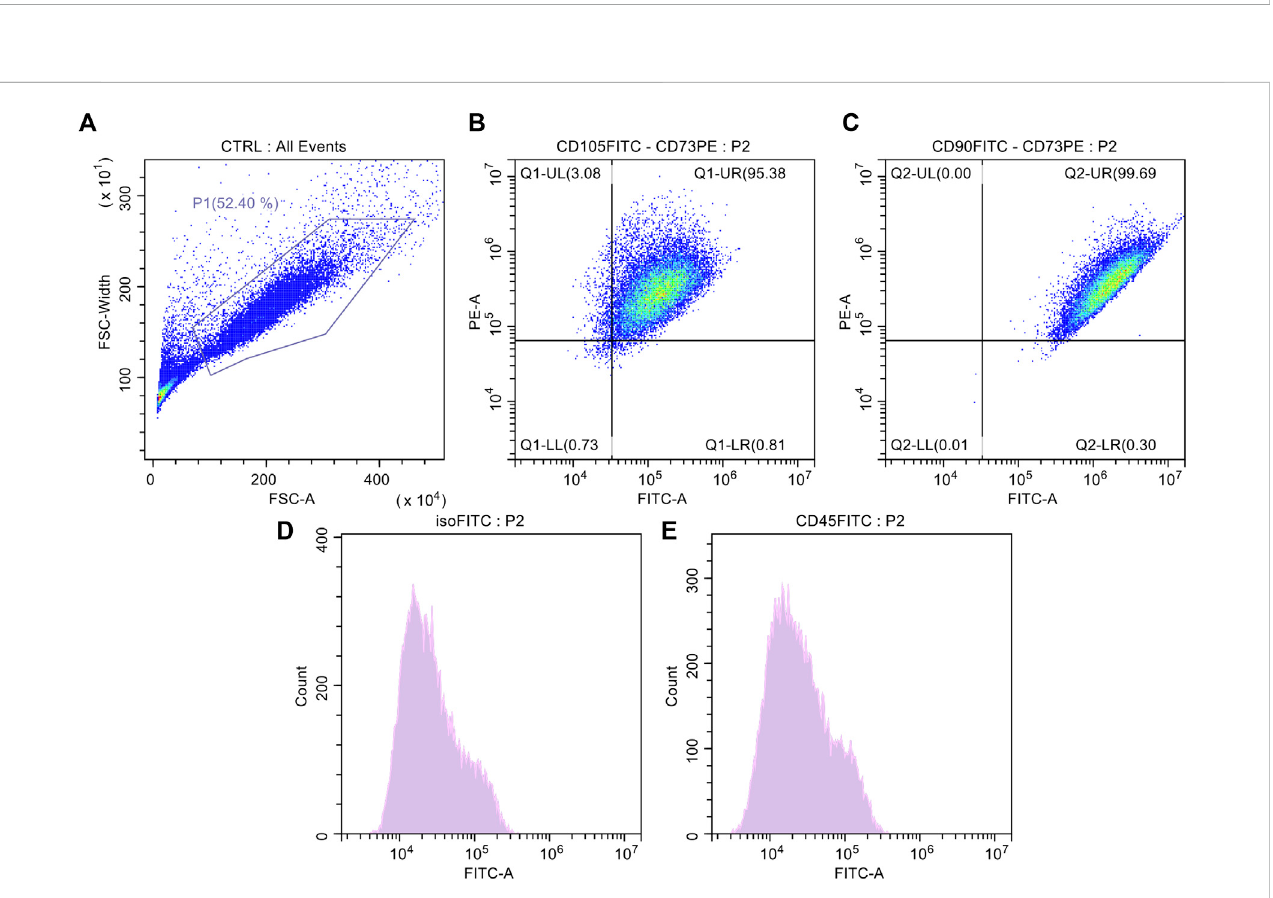
FIGURE 4 Surfaceantigenexpressionsofcultureexpandedadipose-derivedstromalcells(ASCs). (A) Controlcellpopulation; (B) DotplotofcultureexpandedASCs marked with FITC-CD105 and PE-CD73; (C) Dot-plot of culture expanded ASCs marked with FITC-CD90 and PE-CD73; (D) Histogram of culture expanded ASCs marked with FITC-Isotype Control; (E) Histogram of culture expanded ASCs marked with